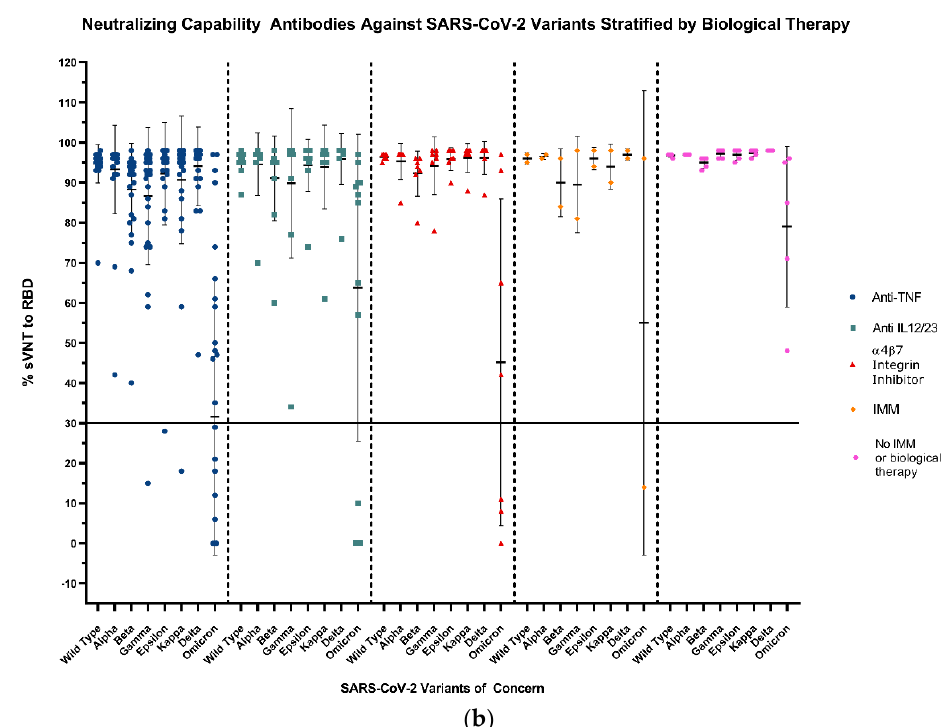
Figure 1. ( a ) Antibody neutralization against receptor binding domain (RBD) of SARS-CoV-2 variants of concern in controls vs. patients with IBD after 60-days of mRNA COVID-19 vaccine. ( b ) A drug therapy mechanism stratifies antibody neutralization against SARS-CoV-2 variants of concern in patients with IBD. All the healthy controls developed detectable antibodies and effective humoral responses against all seven variants of SARS-CoV-2. Although levels against the Omicron variant were lower than those against the other variants, they developed more than 30% neutralization, which did not occur in the IBD group. The dashed line represents the limit for effective antibody neutralization ( ≥ 30%), and the bars represent the mean with standard deviation. ( b ) Twenty-four (24) subjects with IBD did not develop effective neutralizing capability against the Omicron variant. Three subjects (3/24) were receiving anti-IL 12/23 inhibitor, the other three (3/24) subjects were receiving integrin inhibitor, and one (1/24) subject was on IMM. Seventy-one percent (17/24) of those subjects were receiving anti-TNF therapy [10 = adalimumab, 7 = infliximab], two of them (2/17) had a history of COVID-19 infection, and one (1/17) subject did not develop immune neutralization against three other variants: Gamma, Epsilon, and Kappa. The solid line represents the limit for effective antibody neutralization ( ≥ 30%), and bars represent the mean with standard deviation. Anti- TNF: anti-tumor necrosis factor, Anti-IL 12/23: anti-interleukin 12/23, a4b7 integrin inhibitor: alpha 4 and beta 7 integrin inhibitor, IMM: immunomodulator.